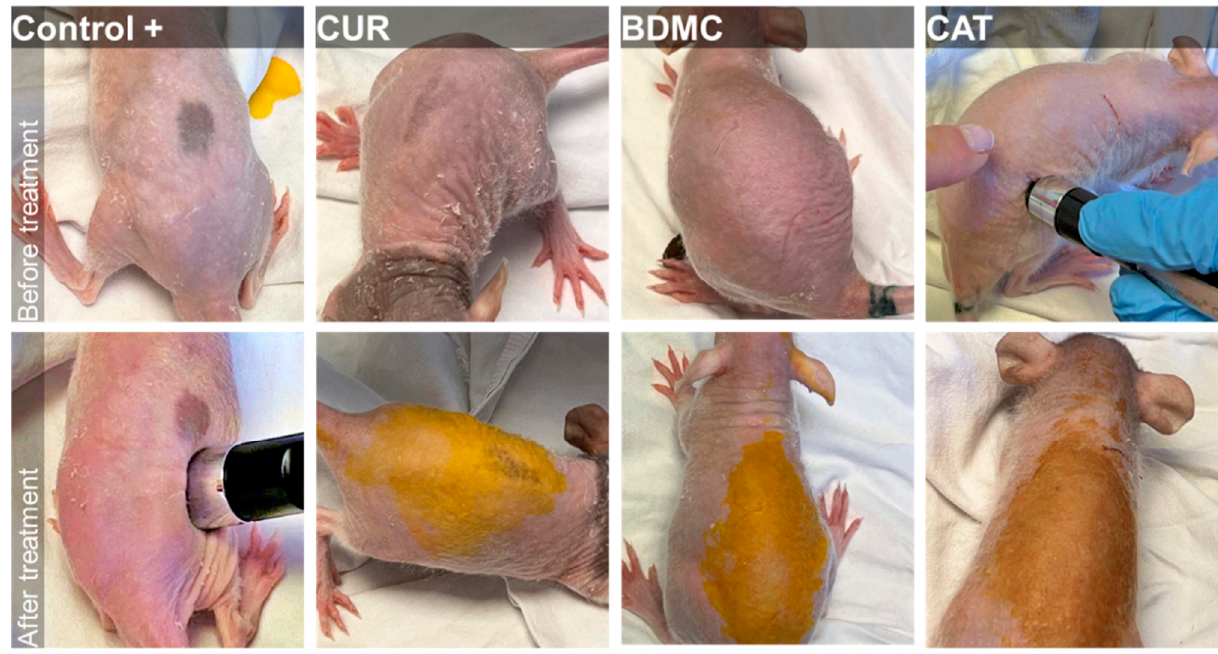
Figure 5. Anti-inflammatory efficacy study. Back of the rats ( n = 6) before (upper panels) and after (lower panels) treatment with xylol and curcuminoids (CAT, CUR or BDMC). Rats treated with xylol but no curcuminoid were taken as the positive control, whereas the ventral skin of the rats was treated only with ethanol and was taken as the negative Control − .